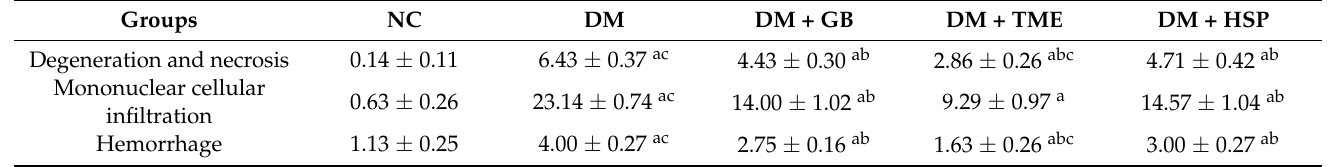
Table 1. Effect of diabetes and different treatments on pancreatic morphology.